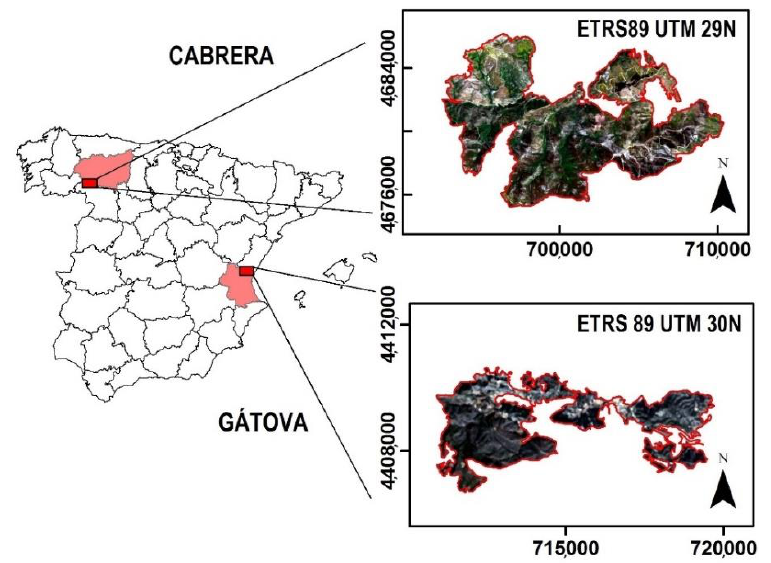
Figure 1. Location of the study areas in the Iberian Peninsula ( left ). Panels on the right show the perimeters of the Cabrera ( top ) and Gátova ( bottom ) wildfires.